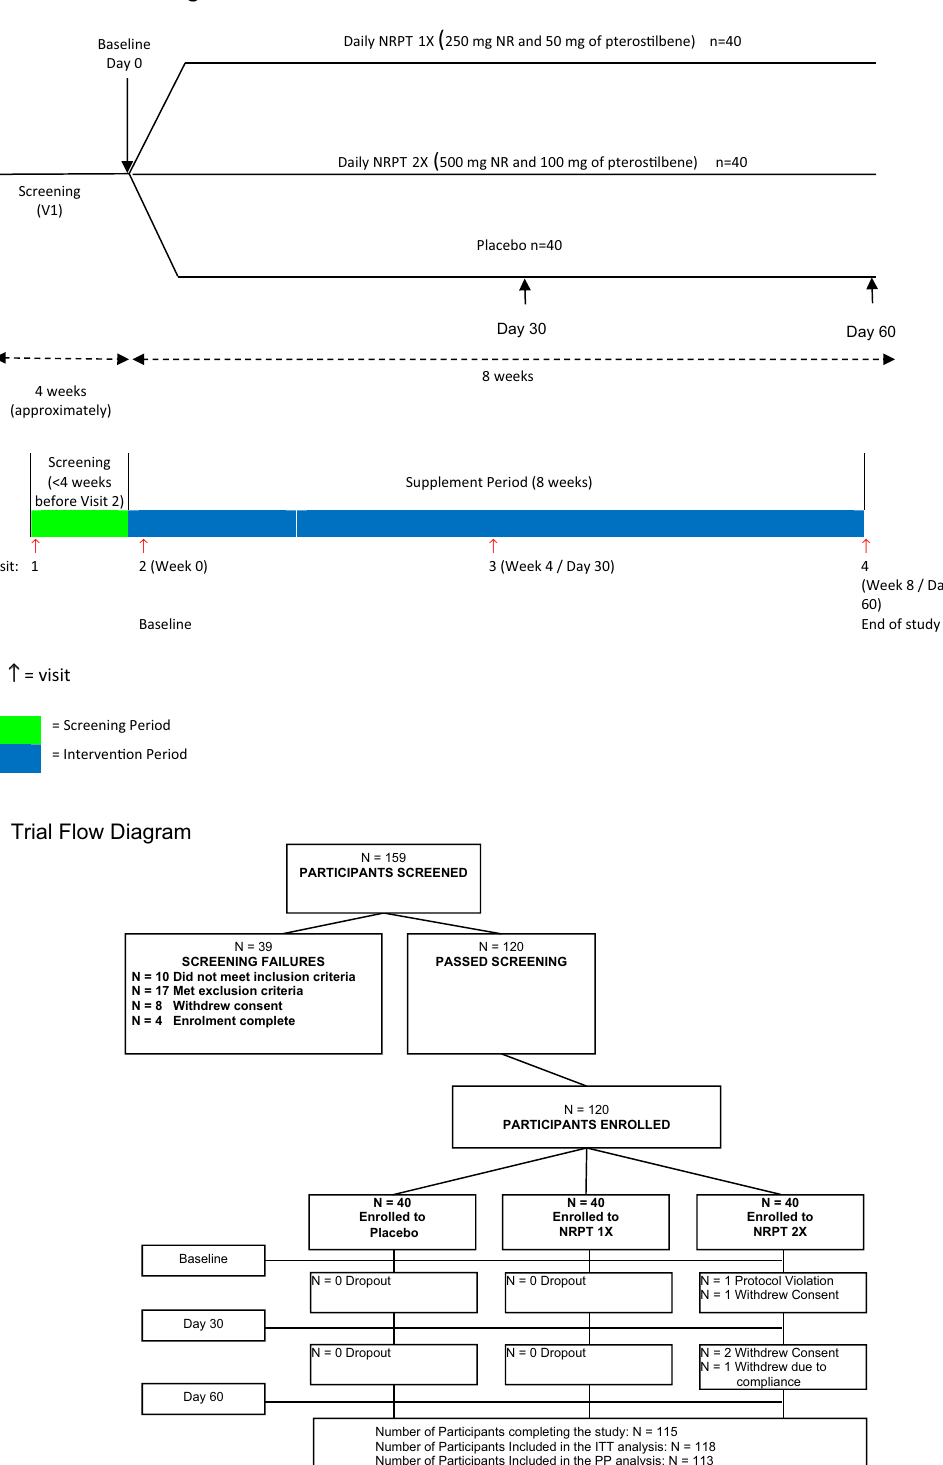
Fig. 1 Clinical trial diagrams. a Clinical Trial Design diagram. Schematic depicting the randomized, double-blind, placebo controlled, three- arm parallel group study. The study consisted of a single eight-week study period. Clinic visits occurred at day 0 (baseline), day 30, and day 60. Subjects were asked to fast 12 h prior to each clinic visit. Each clinic visit consisted of a physical exam including as well as blood draws to evaluate safety and ef fi cacy endpoints of the trial. b Clinical Trial Flow Diagram. Schematic depicting recruitment and disposition of study participants. A total of 159 potential subjects were screened to successfully enroll 120 eligible subjects and randomize them 1:1:1 to the three arms. One-hundred fi fteen subjects completed the 60-day